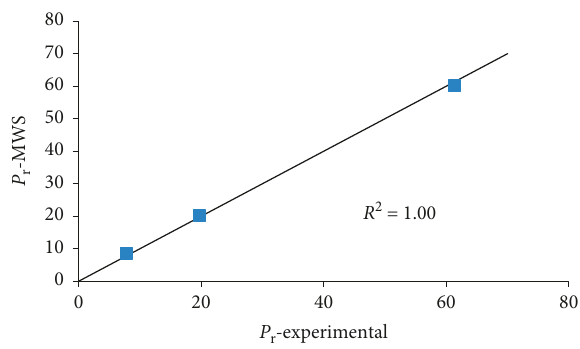
Figure 9: CO 2 relative permeability comparison of experimental data [17] and theoretical